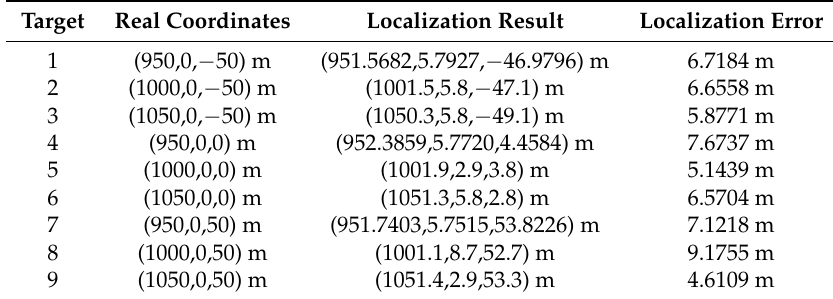
Table 4. Platforms’ position with small error simulation results.